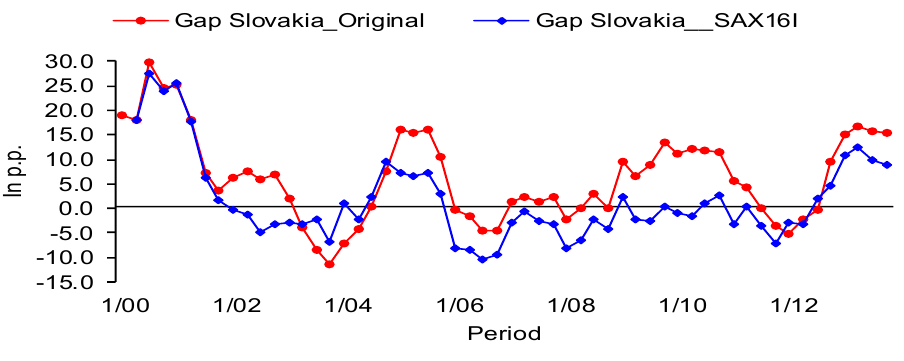
Figure 3. Development of the unemployment gap according to the original model, and after its expansion to include psychological factor on the supply side in